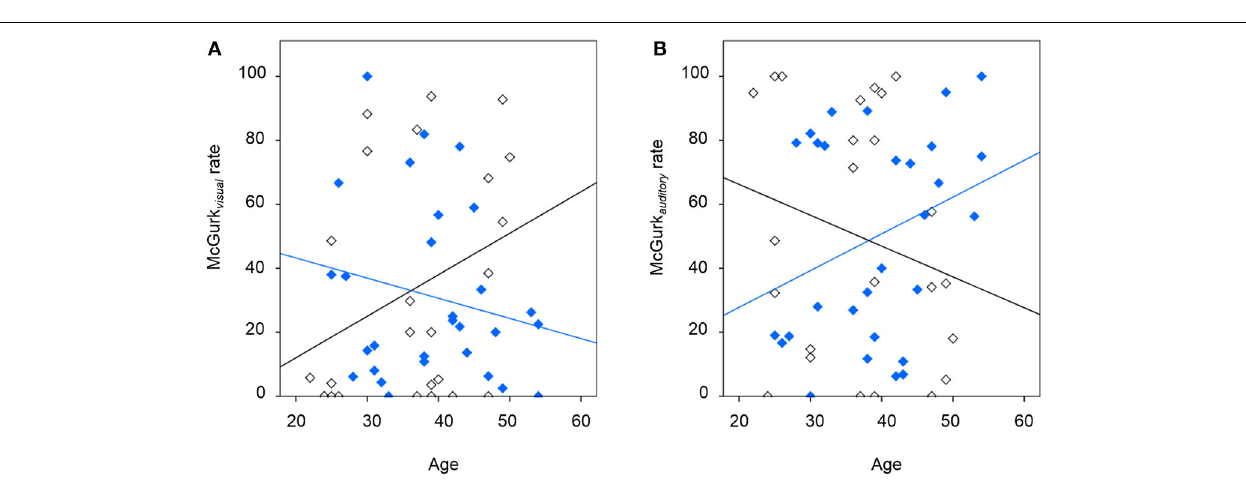
black; R 2 of best-fit line: 0.094), and (B) findings for the McGurk auditory rate for the schizophrenia group (in blue; R 2 of best-fit line: 0.105) and healthy individuals following placebo (in black; R 2 of best-fit line: 0.050).